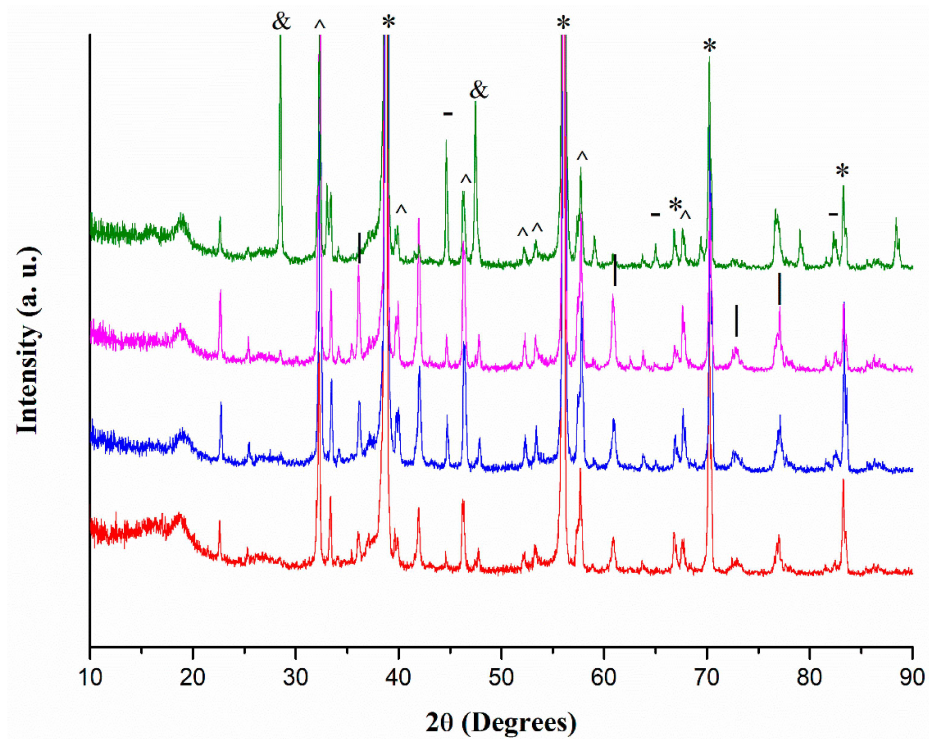
Figure 6. XRD patterns of samples calcined at 1000 ◦ C: Fe 3 O 4 / 1.5CeO 2 (red line); F 3 O 4 :CITR / 1.5CeO 2 (blue line); Fe 3 O 4 :PVP / 1.5CeO 2 (magenta line); Fe 3 O 4 :OA / 1.5CeO 2 (green line). The marked peaks belong to: * NaF (support); & ceria; ˆ cerium ferrite; - Fe; |